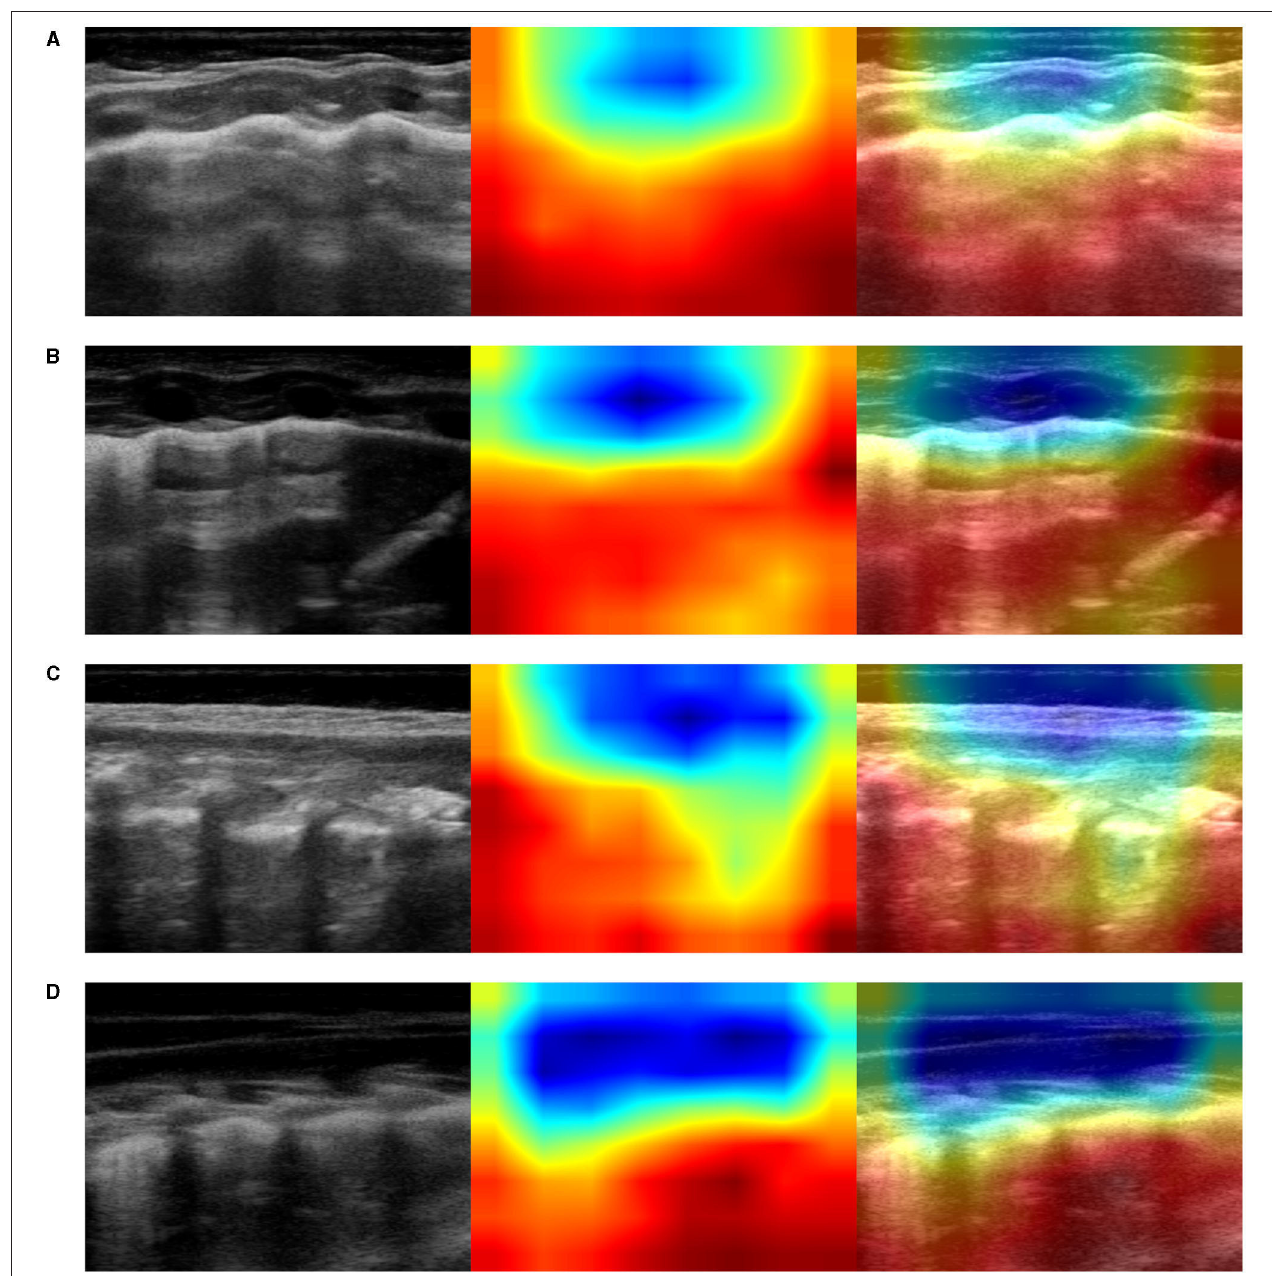
FIGURE 6 | Example of lung ultrasound images correctly predicted by the best performance model (Inception-v3) as bronchiolitis. Left : original LUS image; middle : class activation mapping produced by the Grad-CAM visualization; right : the class activation mapping overlaid transparently on the original LUS image. Note that red and orange regions correspond to high scores for the predicted class and correctly highlight diagnostic-relevant features: (A) irregular short vertical artifacts; (B) irregular pleural line, subpleural consolidation > 2 cm, confluent short and long vertical artifacts; (C) irregular subpleural line, microconsolidations, short vertical artifacts; and (D)